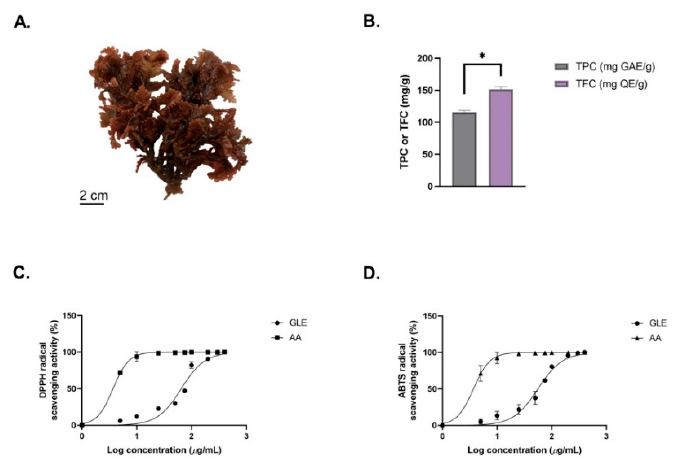
Figure 1. ( A ) Morphological features of the red seaweed Gelidium latifolium . ( B ) Total phenolic content (TPC) and total flavonoid content (TFC) of GLE. ( C ) DPPH radical scavenging activity of GLE. ( D ) ABTS radical scavenging activity of GLE. Data represented are the mean ± SEM of 3 independent experiments; * indicates significant differences between groups ( p < 0.05).